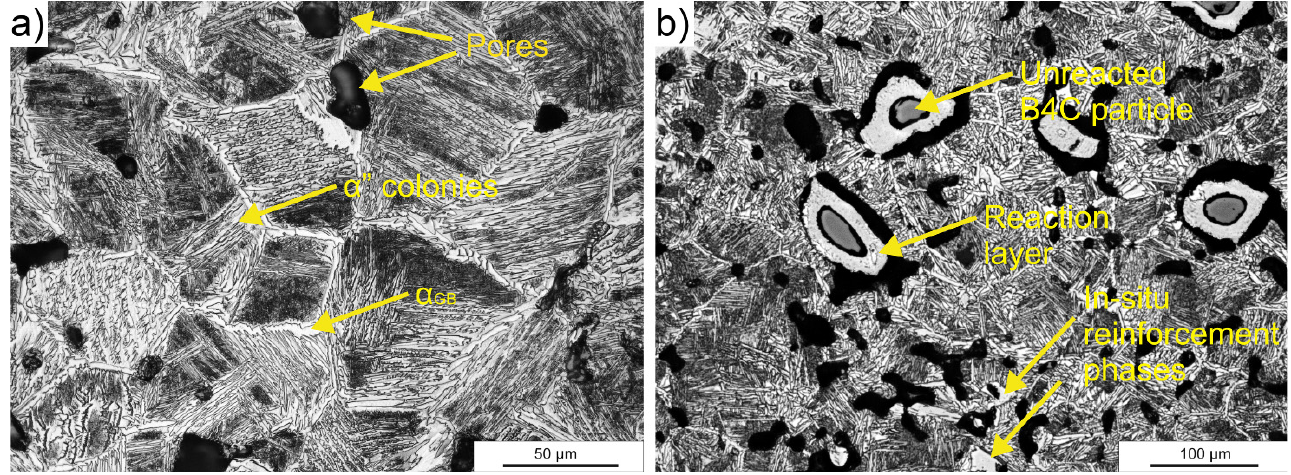
Figure 4. Optical micrographs of as-sintered ( a ) Ti-5553 alloy and ( b ) Ti-5553 + 2% B 4 C composite.